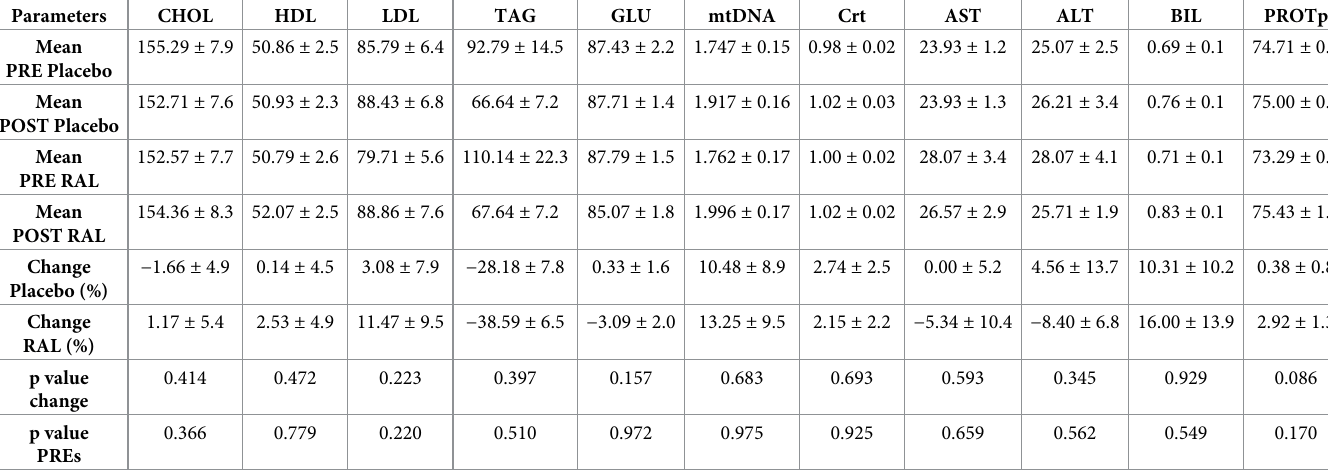
Table 2. Raltegravir (RAL Wilcoxon test results). n = 14 Volunteers; all men; mean age 23.3 ± 1.52. Significance was calculated among absolute values. "p value of change" represents the significance between endpoints after Phase 1 and Phase 2. "p value PREs" represents significance between values in basal circumstances. No changes were significant.